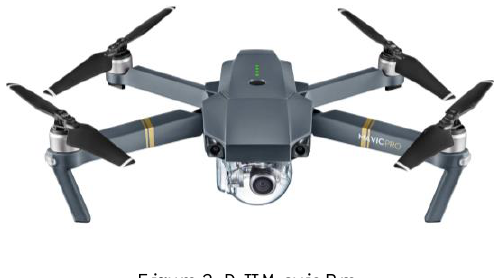
Figure 2. DJI Mavic Pro.